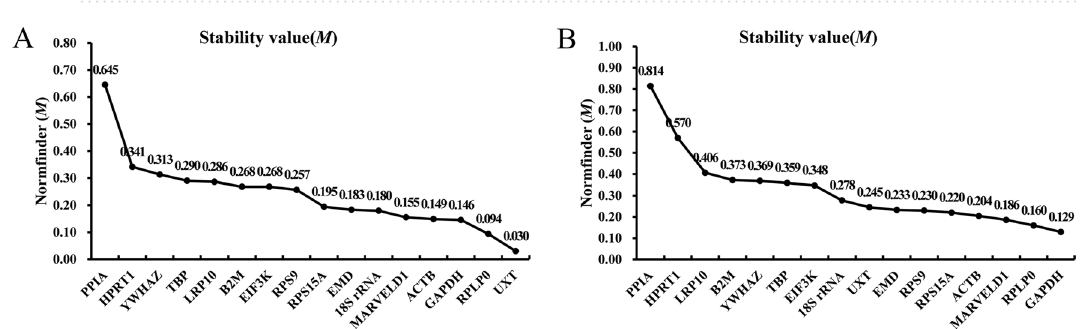
Figure 3. Expression stability and optimal reference genes among the candidate reference genes were determined using the GeNorm program. ( A ) Stability of candidate reference genes during proliferation of bovine SMSCs. ( B ) Optimal reference genes for proliferation of SMSCs. ( C ) Stability of candidate reference genes during differentiation of bovine SMSCs. ( D ) Optimal reference genes for use during in vitro induction of differentiation of SMSCs.